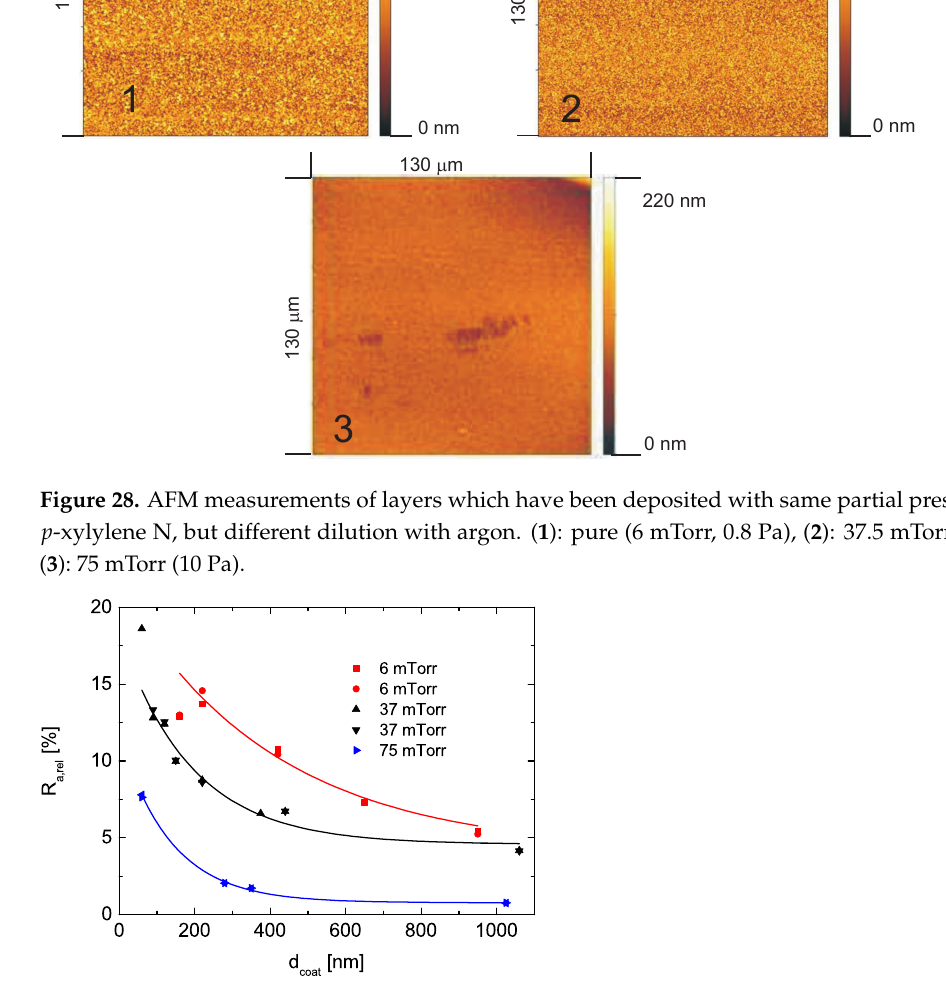
Figure 29. Relative roughness (hole depth ÷ layer thickness as function of absolute layer thickness) for three different pressures (parylene N). 6 mTorr is the pure ambient, the higher pressures are caused by dilution with